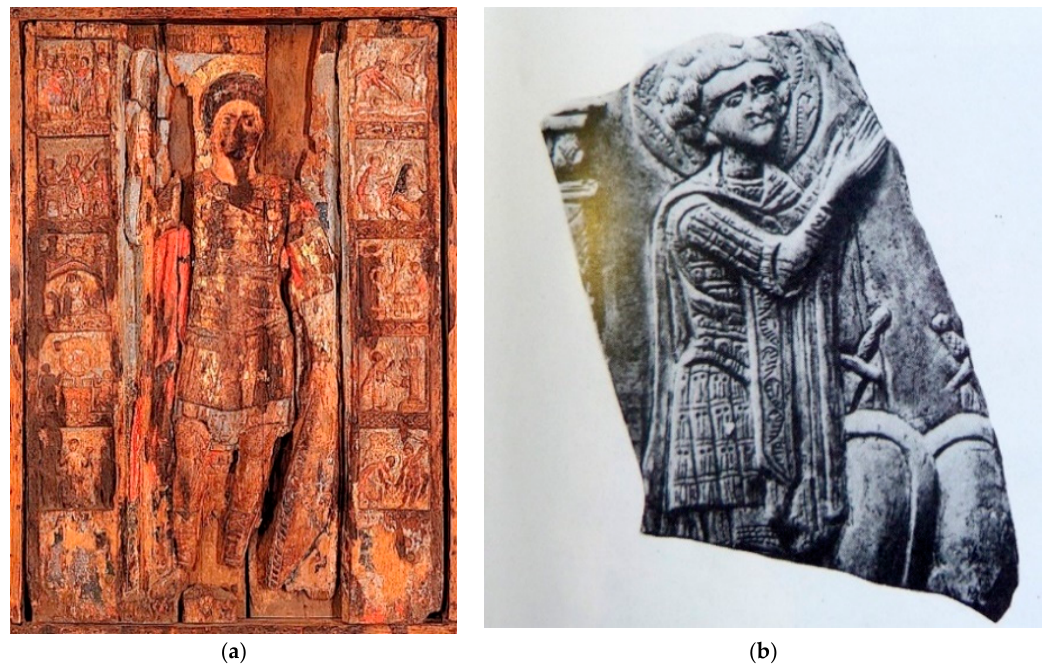
Figure 10. ( a ) Wooden Vita icon of St George, Constantinople, 12th c. (?). National Art Museum of Ukraine, Kiev. © With permission of the National Museum of Ukraine (Kyiv, Ukraine). ( b ) Fragmentary 12th-century steatite icon depicting St George praying, Constantinople (?), 12th c. Kiev, Museum of Western and Oriental Art. Source: (Kalavrezou-Maxeiner 1985).